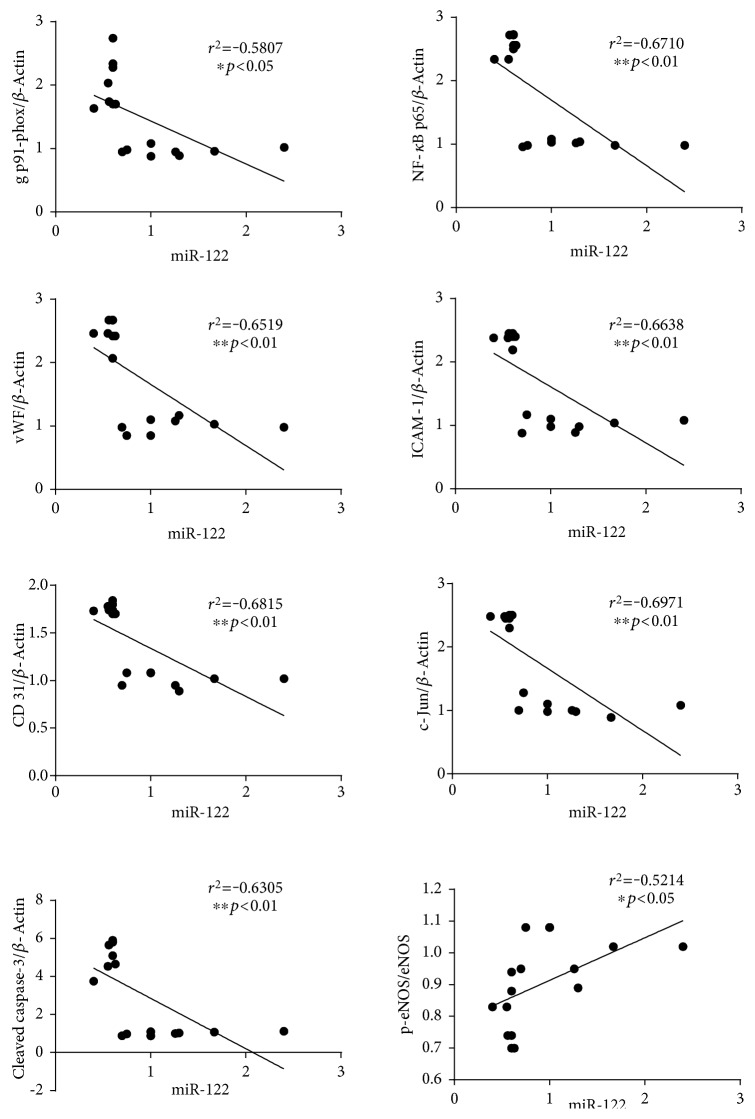
Correlation analysis between miR-122 and protein expression levels in the SHRSP strain. Scatter plots showing the results of the correlation analysis performed between miR-122 expression level and each examined protein level in the brain of SHRSP.